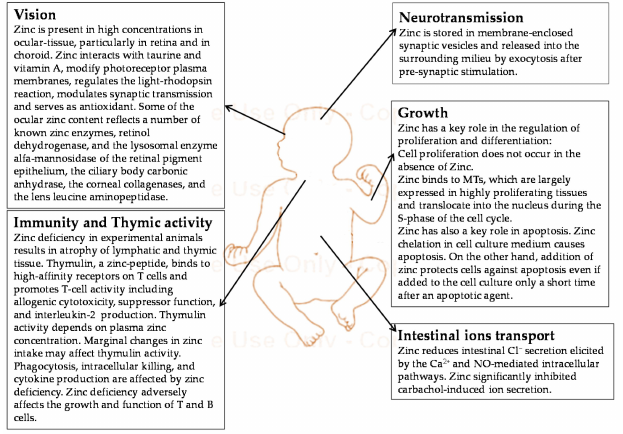
Figure 2. Zinc functions in early life